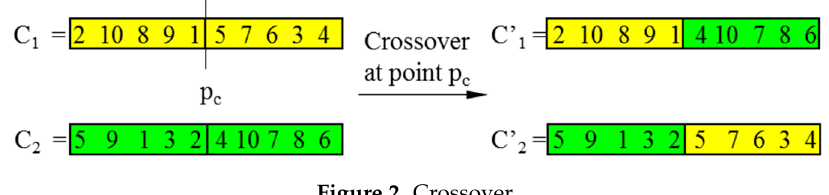
Figure 2. Crossover.